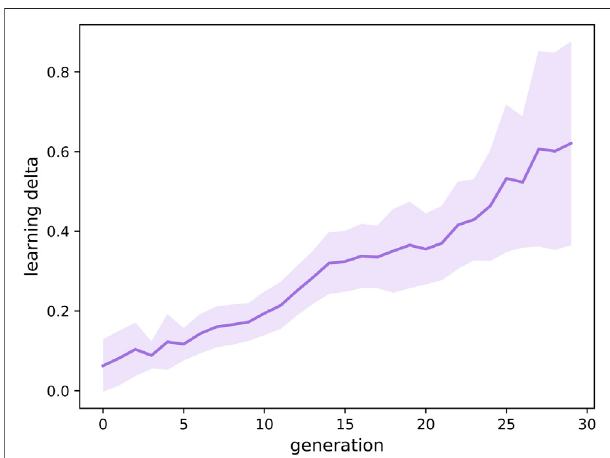
FIGURE 14 | Progression of the learning Δ , the difference between the robots performance with its learned brain and the performance with its inherited brain, over the course of evolution averaged over 10 runs. The plot illustrates that the learning delta is growing across generations.